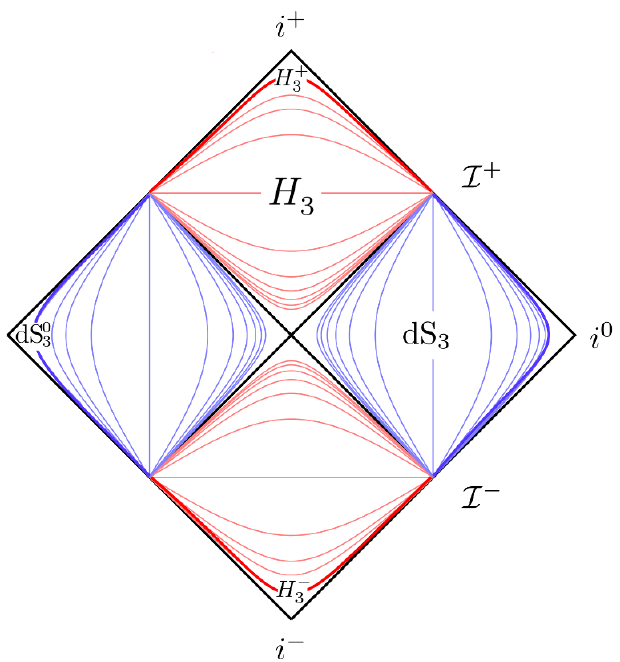
Figure 1 . Penrose diagram of hyperbolic slicing of Minkowski space. The slices correspond to surfaces of constant τ . The slices in the past and future lightcones of the origin have the geometry of H , and the slices with spacelike separation from the origin have the geometry of dS 3